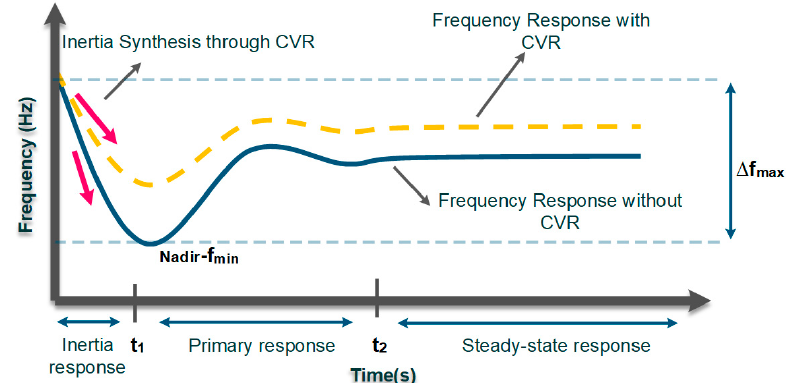
Figure 3. Inertia synthesis and frequency support via CVR.